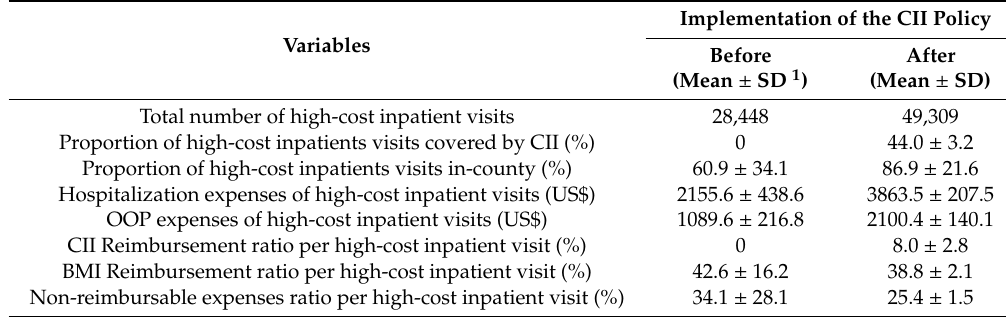
Table 2. Key indicators of policy e ff ects in Xiantao.